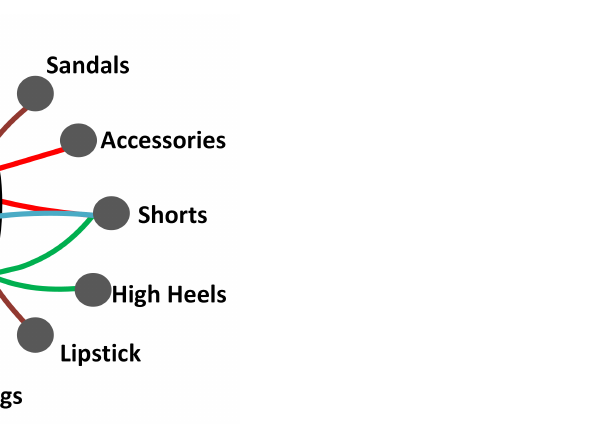
Figure 3. An illustration of the fashion hypergraph based on the dataset, where each circle indicates a category and each hyperedge represents the matching interactions between multiple categories (i.e., they appear in an identical